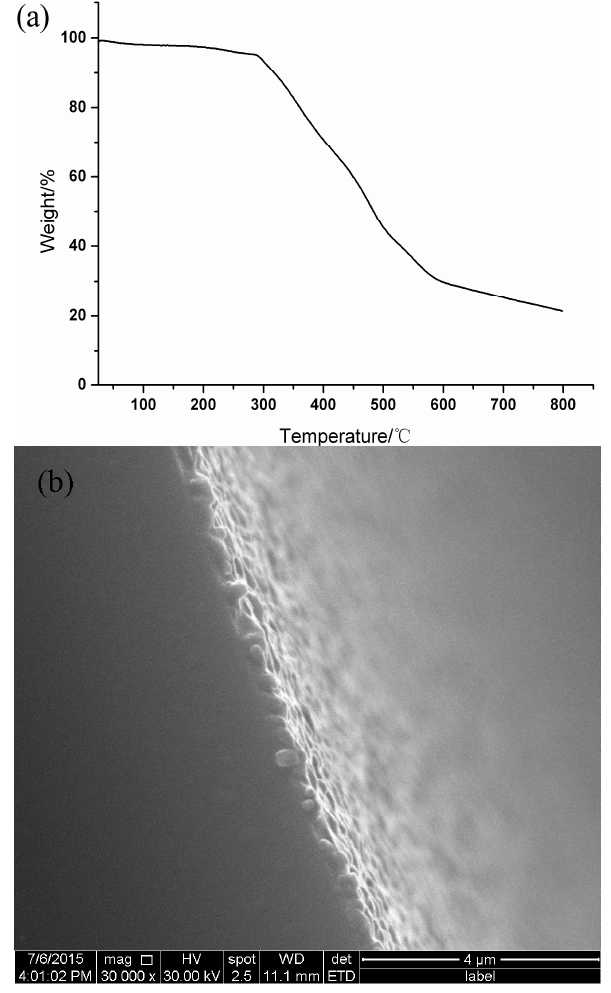
Figure 1. ( a ) TGA of pentyl cage; ( b ) SEM image of the thickness of stationary phase coating in part of the pentyl cage-coated capillary column. Table 1. McReynolds constants of the pentyl cage-coated capillary column at 120 °C.